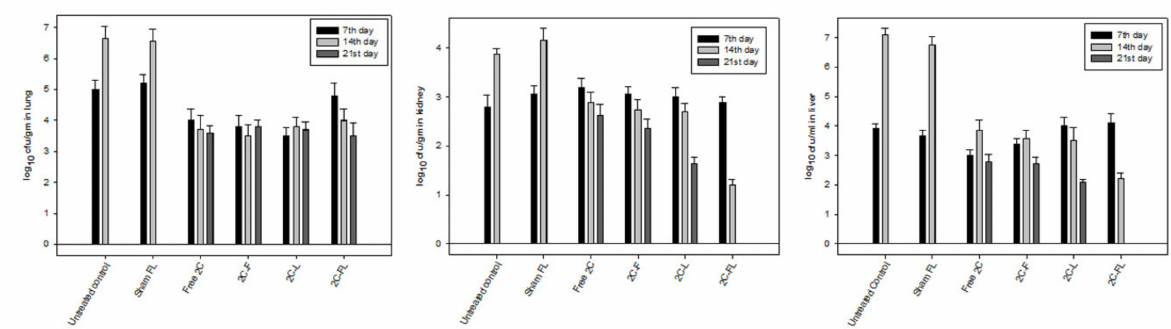
Figure 7. Antifungal efficacy of 2C-encapsulated formulations on the fungal burden in C. albicans- -infected mice. Antifungal activity was detected as a reduction in fungal load at the 7th, 14th, and 21st days post-infection. Data are presented as the mean ± SD CFU/organ of three independent experiments.